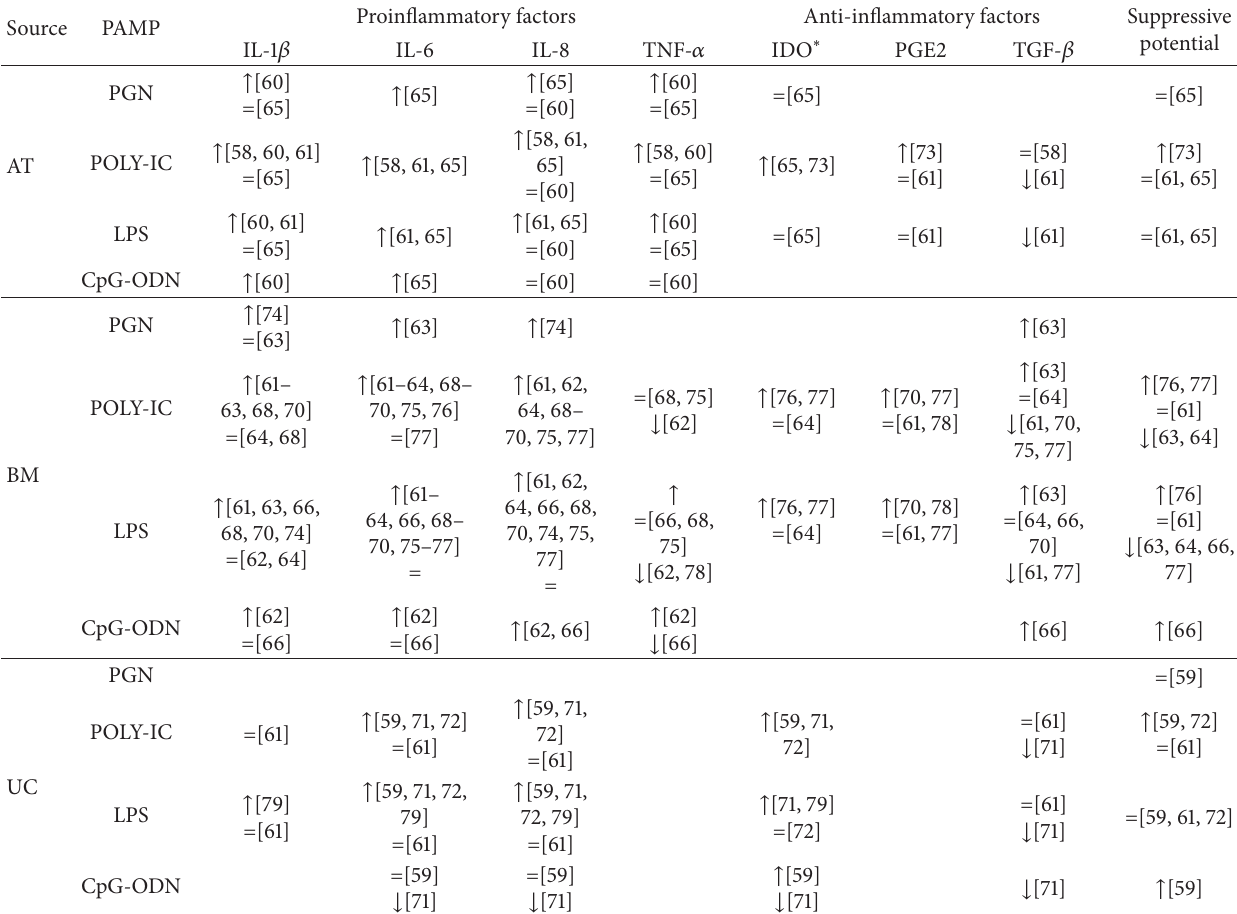
Table 3: Effects of Toll-like receptors on MSCs from different